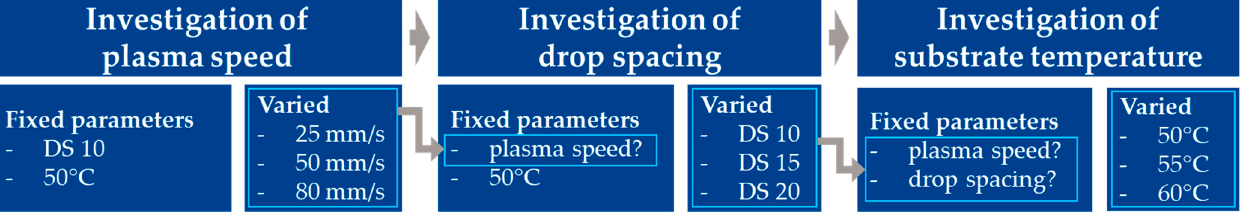
Figure 2. Schematic process parameter sets for inkjet printing experiments.